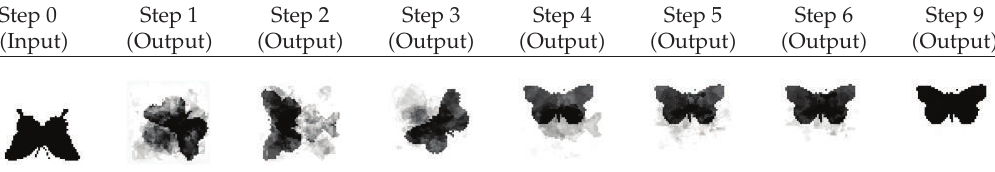
Table 13: Network recall using a di ff erent picture: another example of butterfly.